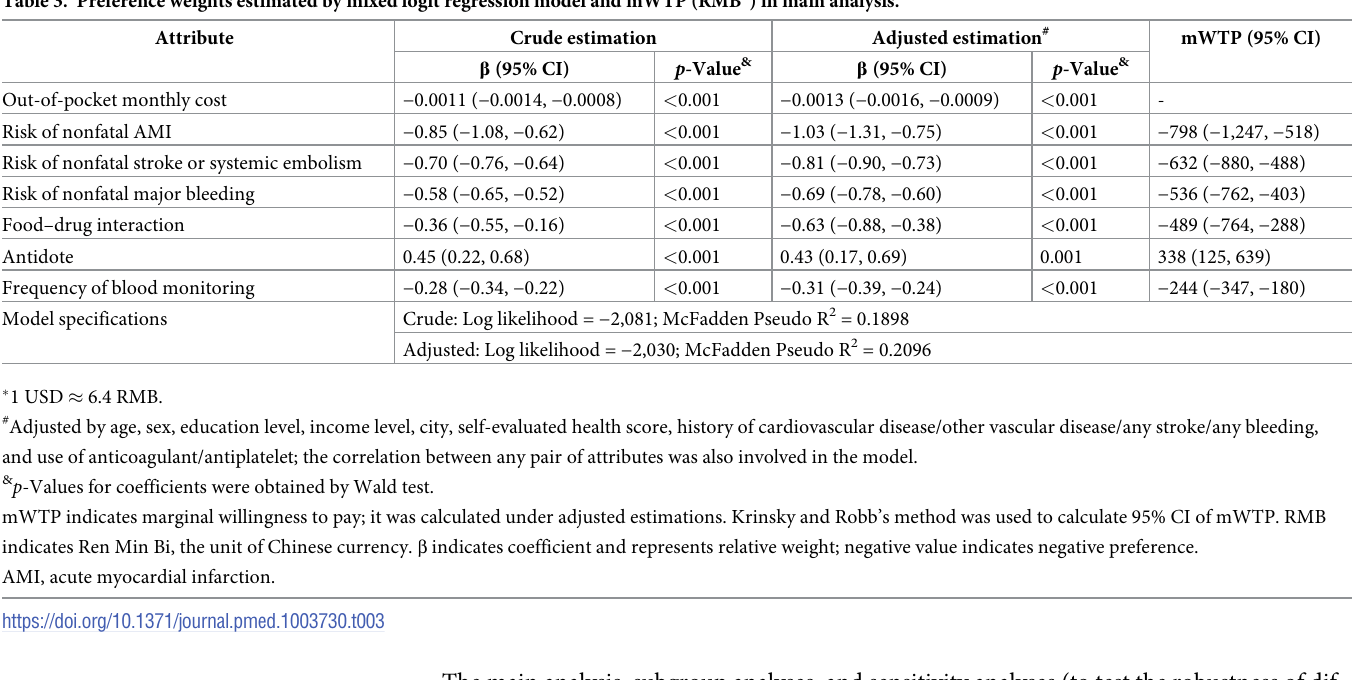
Table 3. Preference weights estimated by mixed logit regression model and mWTP (RMB � ) in main